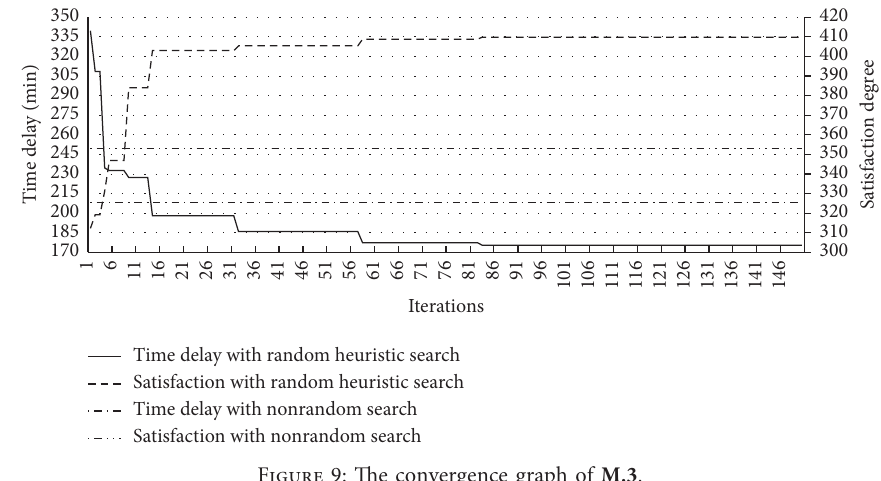
Figure 9: The convergence graph of M.3 .